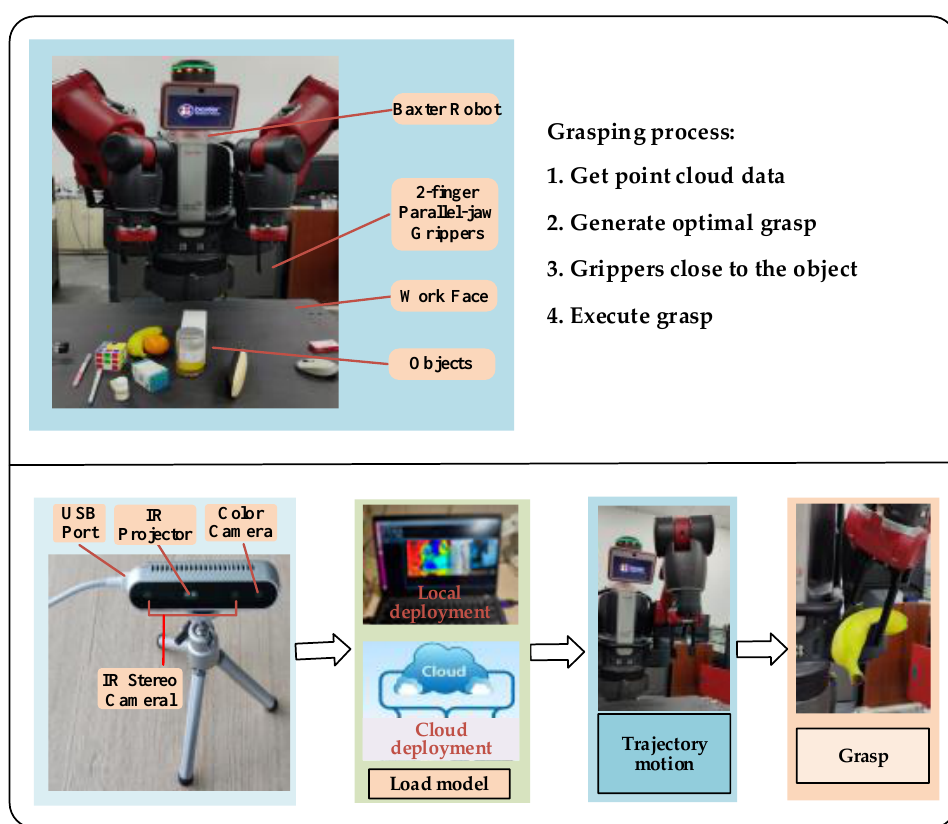
Figure 17. Grasping experiment frame.